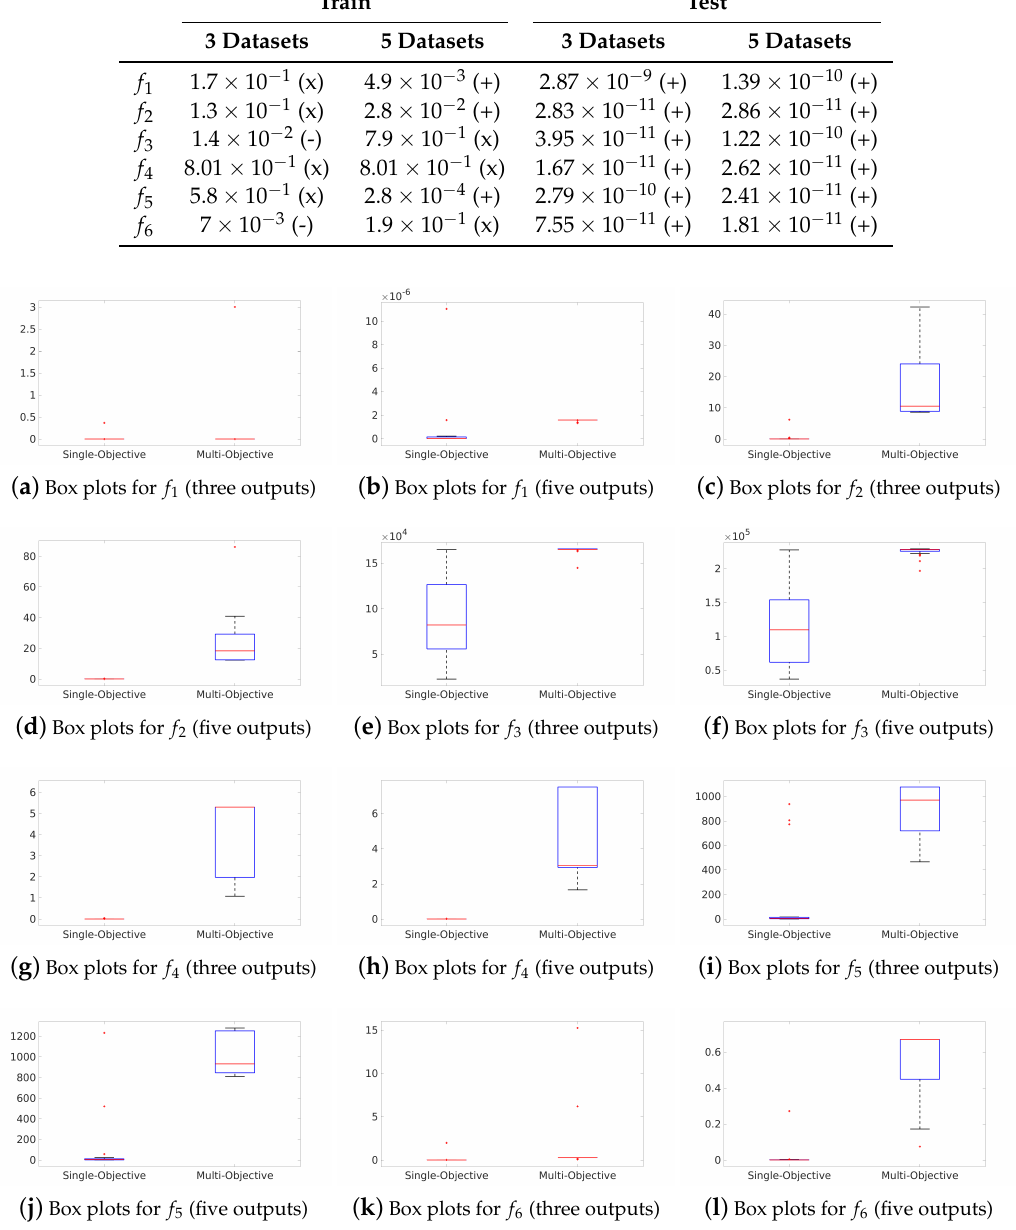
Figure 3. Box plots of accuracy for each algorithm and benchmark algebraic expression in test